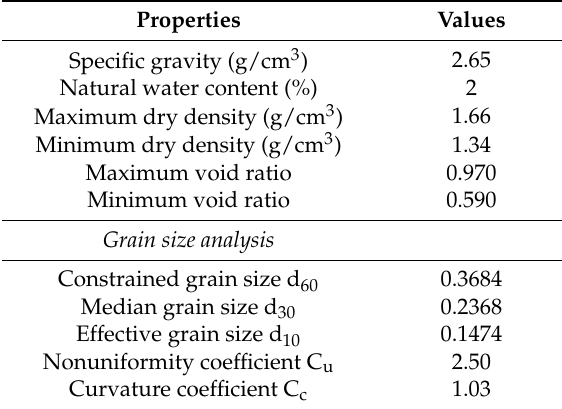
Table 1. Physical and mechanical properties of sand used in this experiment.